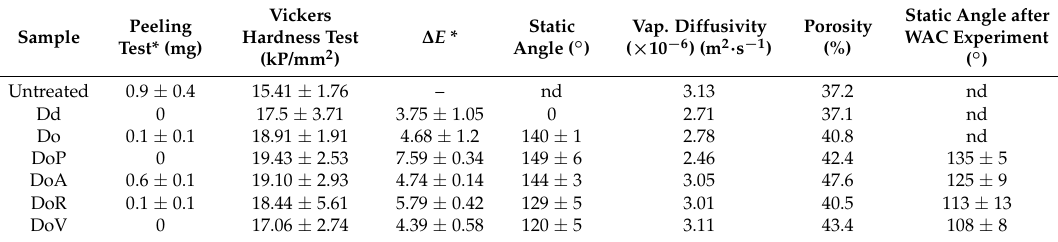
Table 4. A summary of performance of ethylsilicate consolidants.